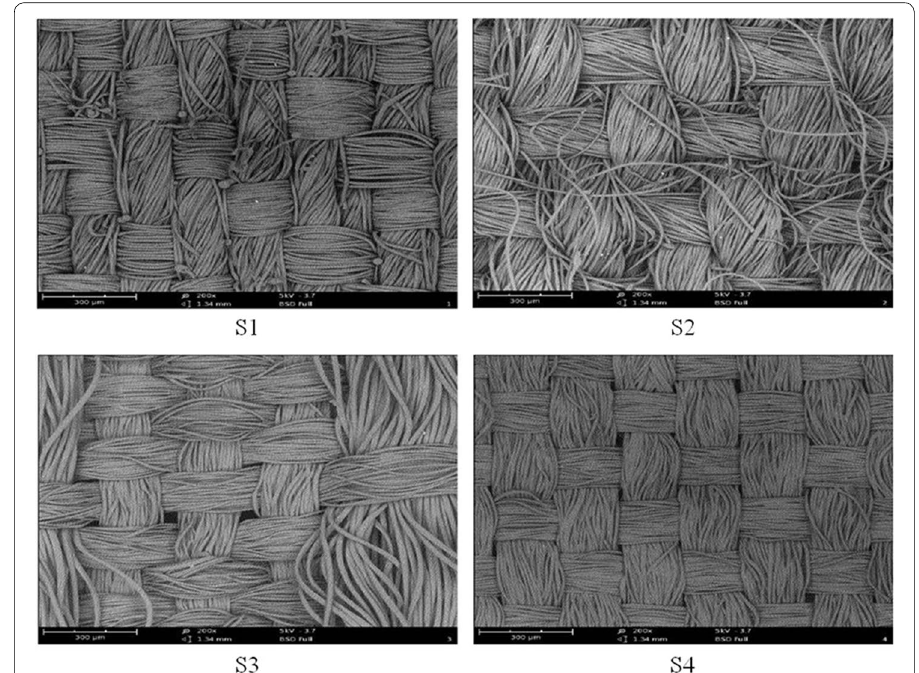
Fig. 1 Morphologies of SEM photos of 4 fluorescent fabric